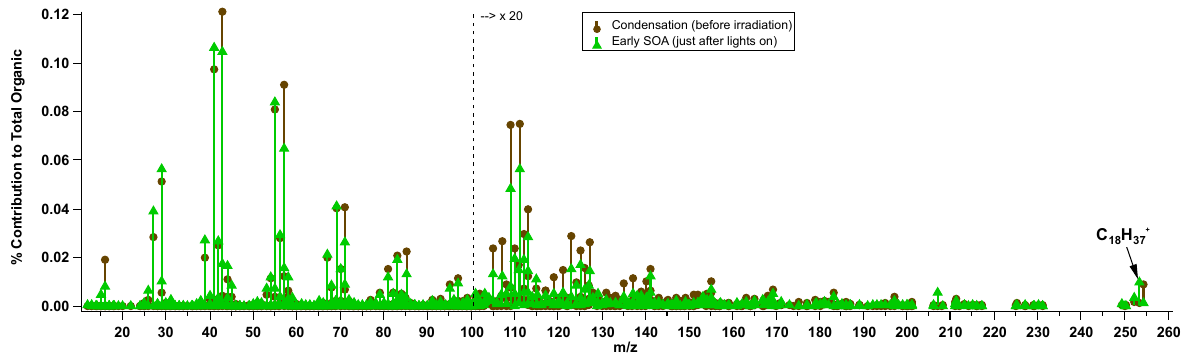
Fig. 9. Mass spectrum of octadecane condensing onto the seed before irradiation, and the relative mass spectrum just after lights on. The hypothesized octadecane-equivalent hydroperoxide fragment is marked at m/z 253.